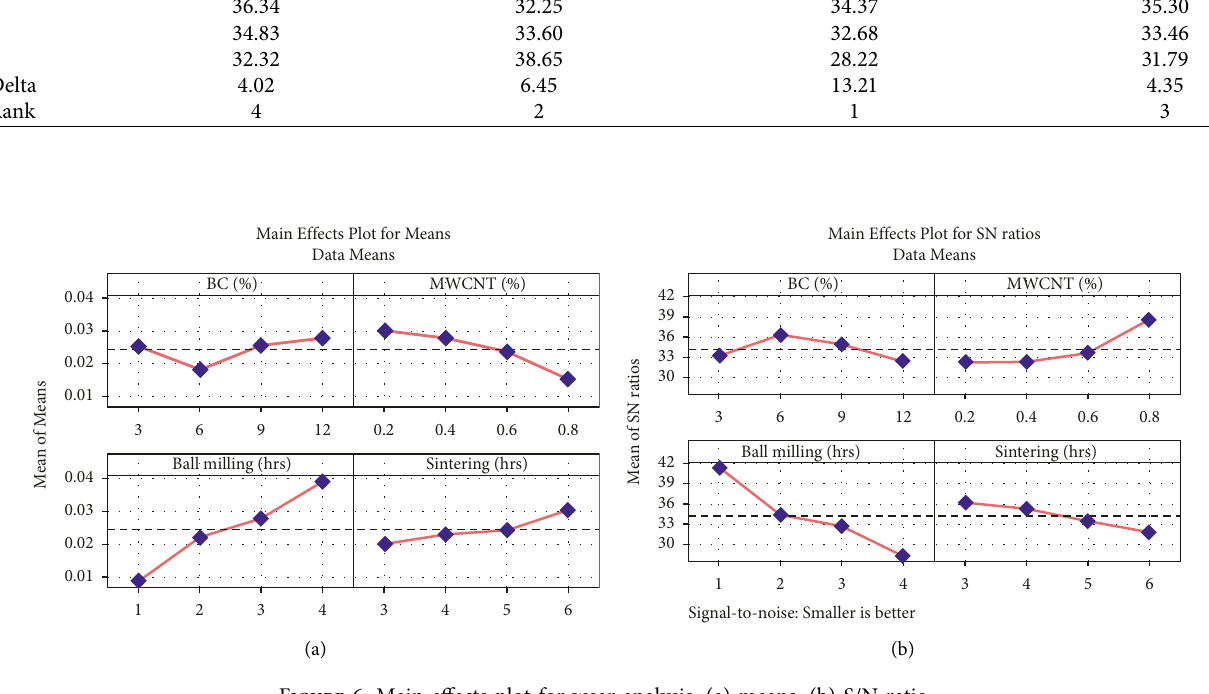
Figure 6: Main effects plot for wear analysis: (a) means; (b) S/N ratio.